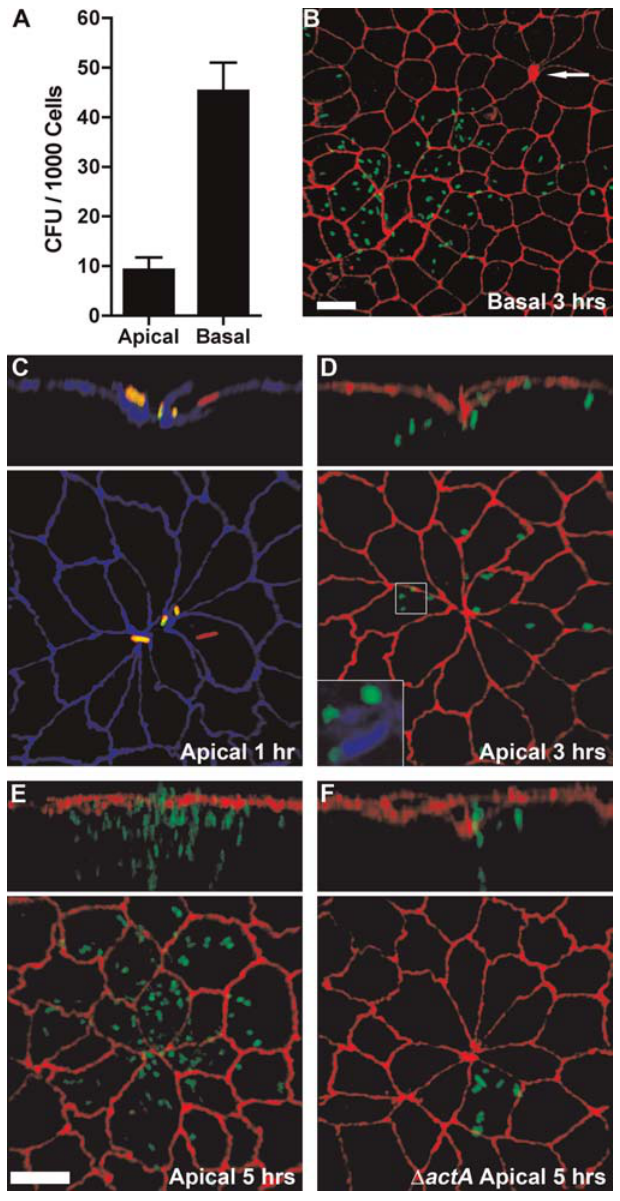
Figure 1. Invasion and Replication of L. monocytogenes at Multicellular Junction Sites Polarized MDCK monolayers on Transwell filters were infected from the apical (A, C–F) or basal (A and B) sides with L. monocytogenes . (A) Viable CFUs of intracellular L. monocytogenes were determined after gentamicin treatment. Means and standard deviations from